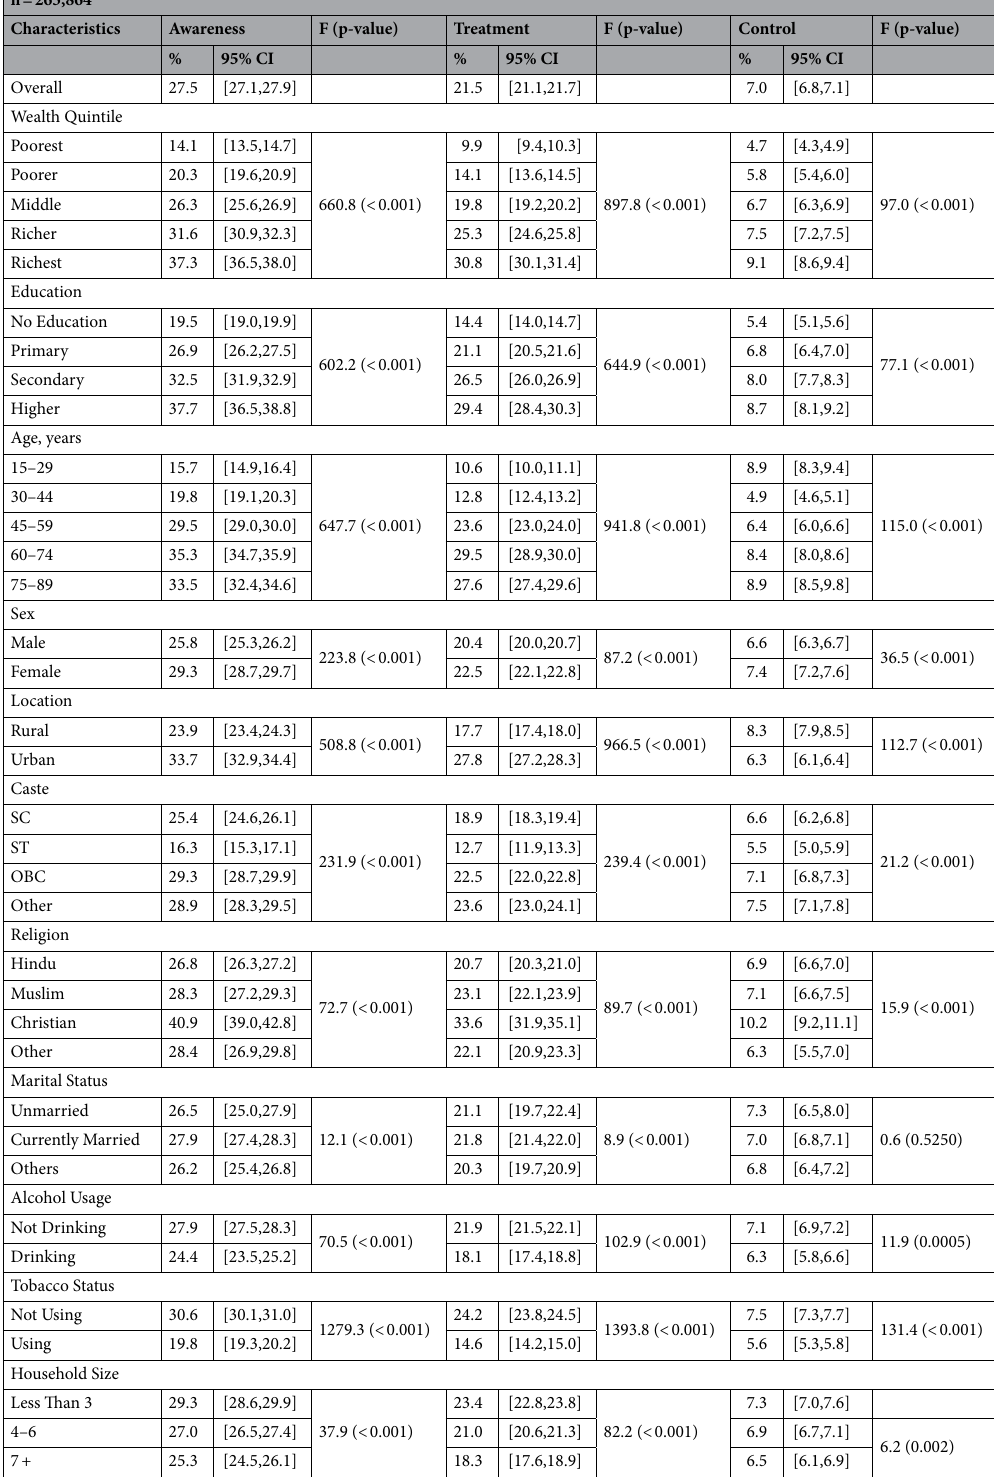
Table 2. Adjusted percent aware, treated and controlled among those with diabetes among adults in India,